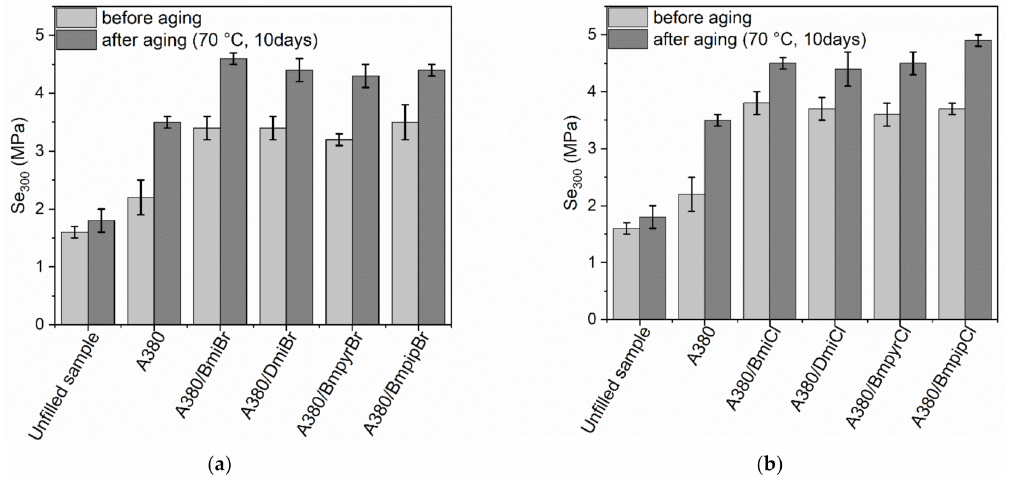
Figure 5. Influence of thermo-oxidative aging on the stress at 300% relative elongation (Se 300 ) of the silica-filled NR vulcanizates containing ILs with: ( a ) bromide anion; ( b ) chloride